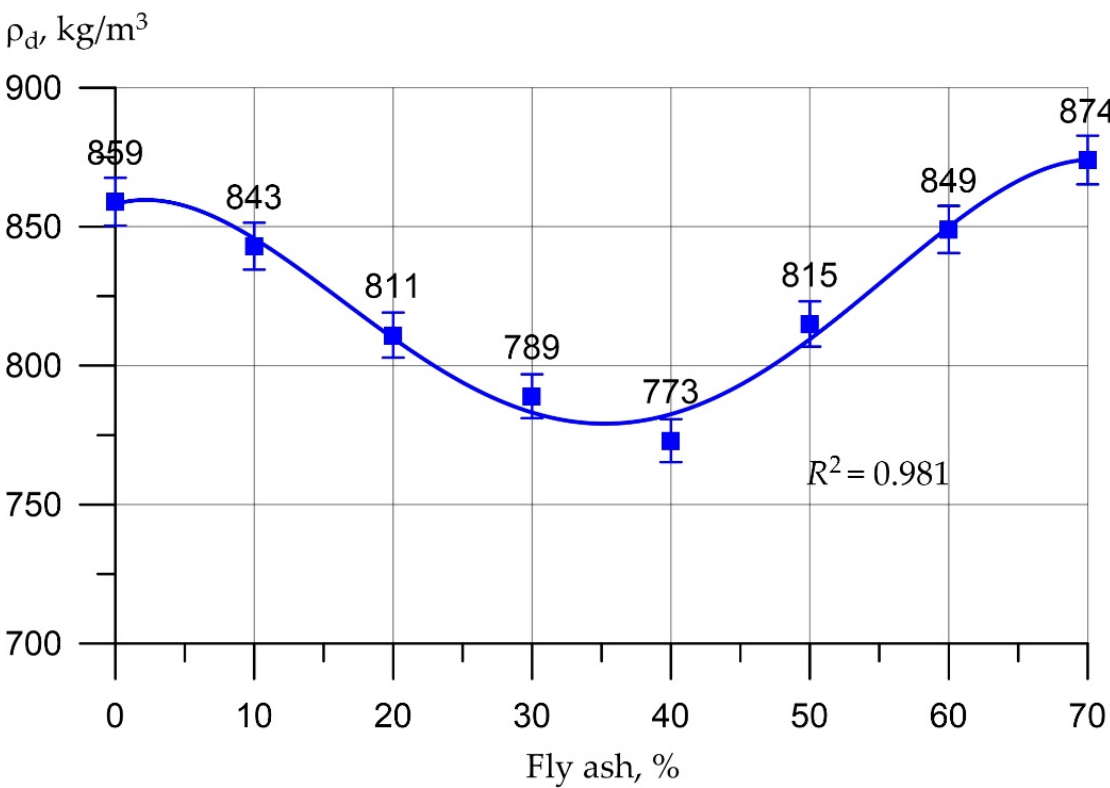
Figure 5. Dependence of the DD of FFC samples in a dry state on various percentages of replacing cement with fly ash.